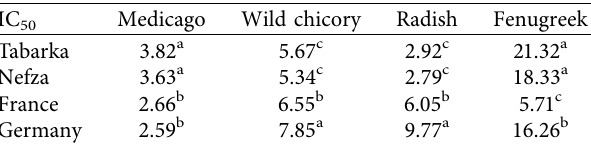
Table 8: IC 50 of the aqueous extract according to the origin of M. officinalis and seeds tested.